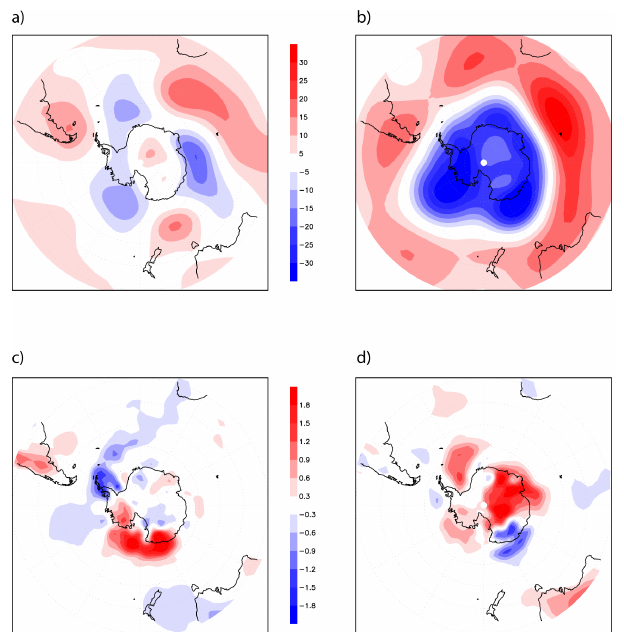
Figure 2. Composites of 500hPa geopotential height anomalies (in m) over 1979–2010: (a) state 1 (blocking) and (b) state 2 (positive SAM); and composites of surface air temperature (in ◦ C) (c) state 1 (blocking), (d) state 2 (positive SAM). Only persistent states which last at least 5 days have been used.